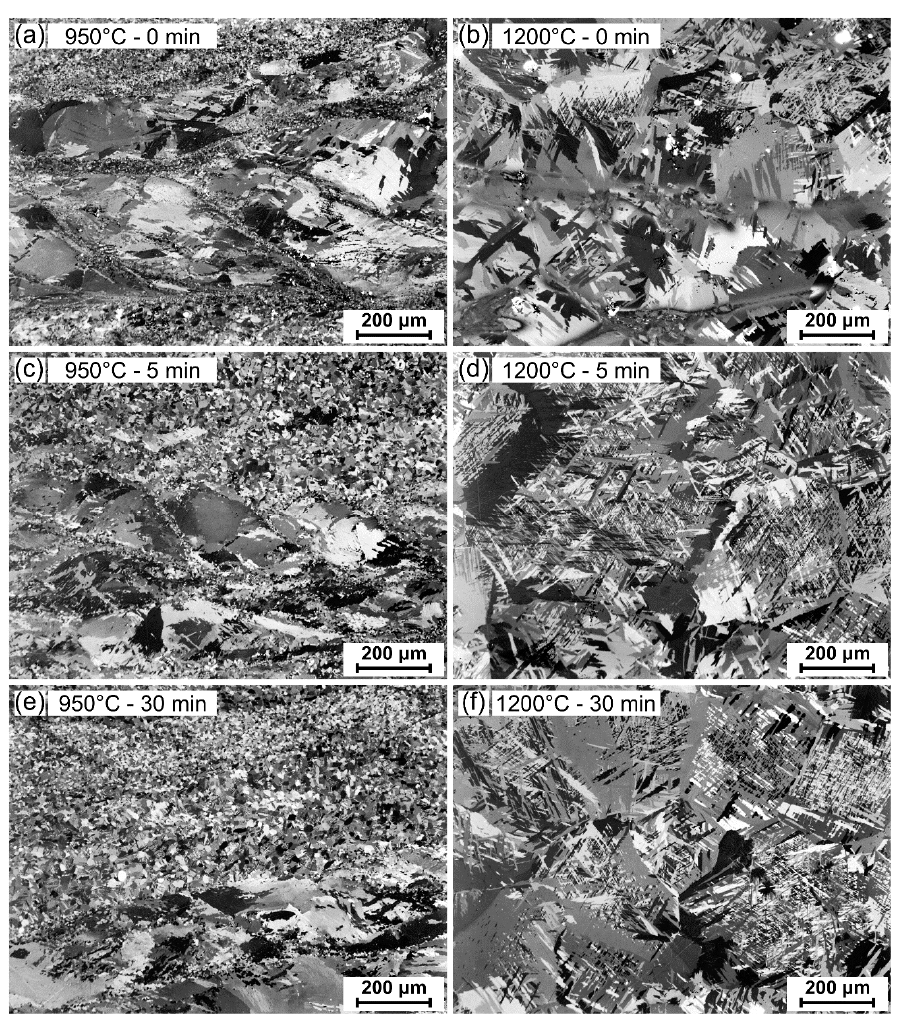
Figure 5. Cross-polarized light micrographs showing the microstructural evolution of the Ti-6Al-4V swarf specimens with increasing FAST dwell temperature and/or dwell time, when using a fixed dwell pressure and heating rate: ( a ) 950 °C for 0 min; ( b ) 1200 °C for 0 min; ( c ) 950 °C for 5 min; ( d ) 1200 °C for 5 min; ( e ) 950 °C for 30 min; ( f ) 1200 °C for 30 min.